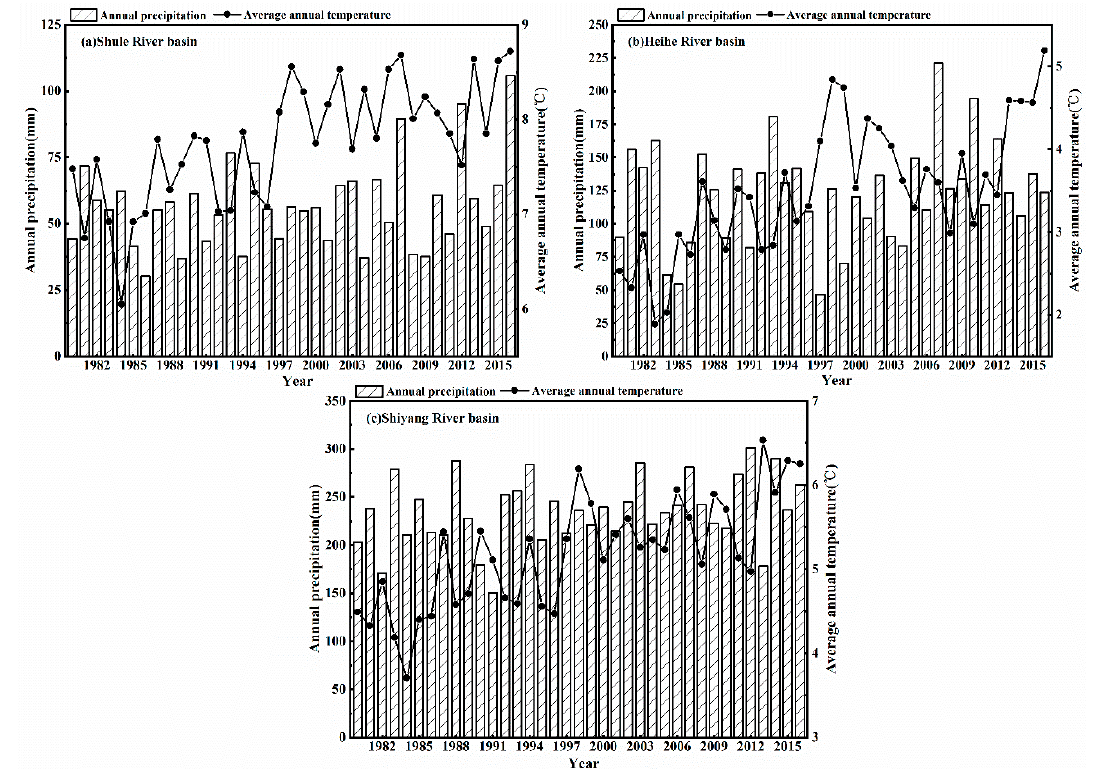
Figure 9. Diagram of annual precipitation and average annual temperature of the Hexi inland river basin during 1980–2016: ( a ) the Shule River basin; ( b ) the Heihe River basin; and ( c ) the Shiyang River basin.